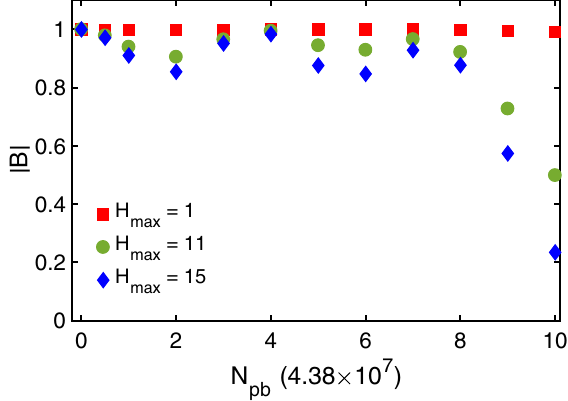
FIG. 15. Dependence of the bunching factors j B j on the number of electrons per microbunch including different radiation har- monics. The bunching factor is evaluated at s ¼ 2 . 1